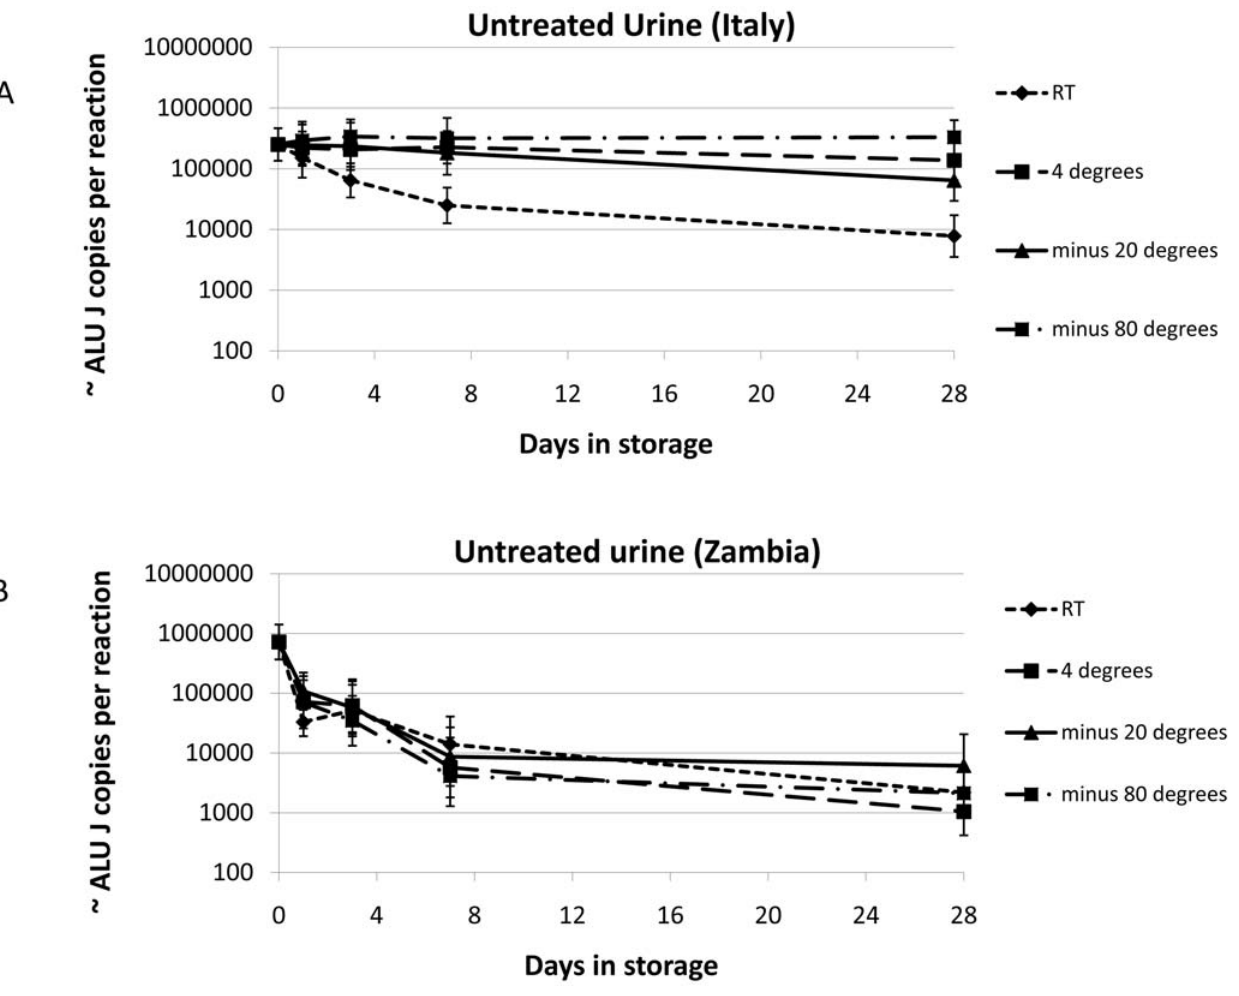
Figure 3. The effect of storage temperature on untreated urine from two populations over 28 days. Human DNA, as measured by the ALU J assay, is quite stable in all temperatures in Italy (A) except room temperature where considerable degradation is observed. In Zambia (B) human DNA is rapidly lost at all of the temperatures examined. Geometric means + / 2 95% confidence intervals are plotted for each treatment.